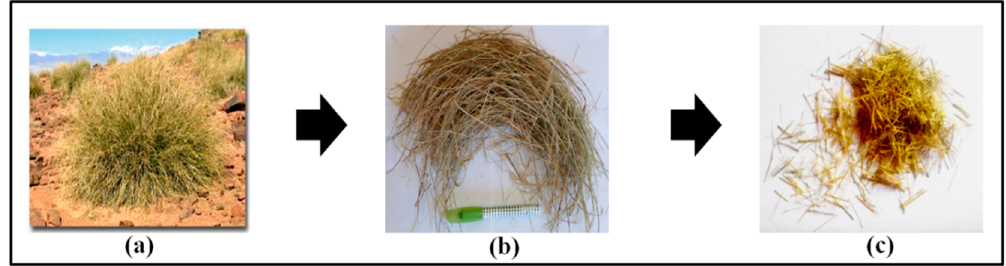
Figure 1. Steps of alfa fiber (AF) preparation: ( a ) alfa plant, ( b ) crushed alfa stem after drying process and ( c ) used AF.